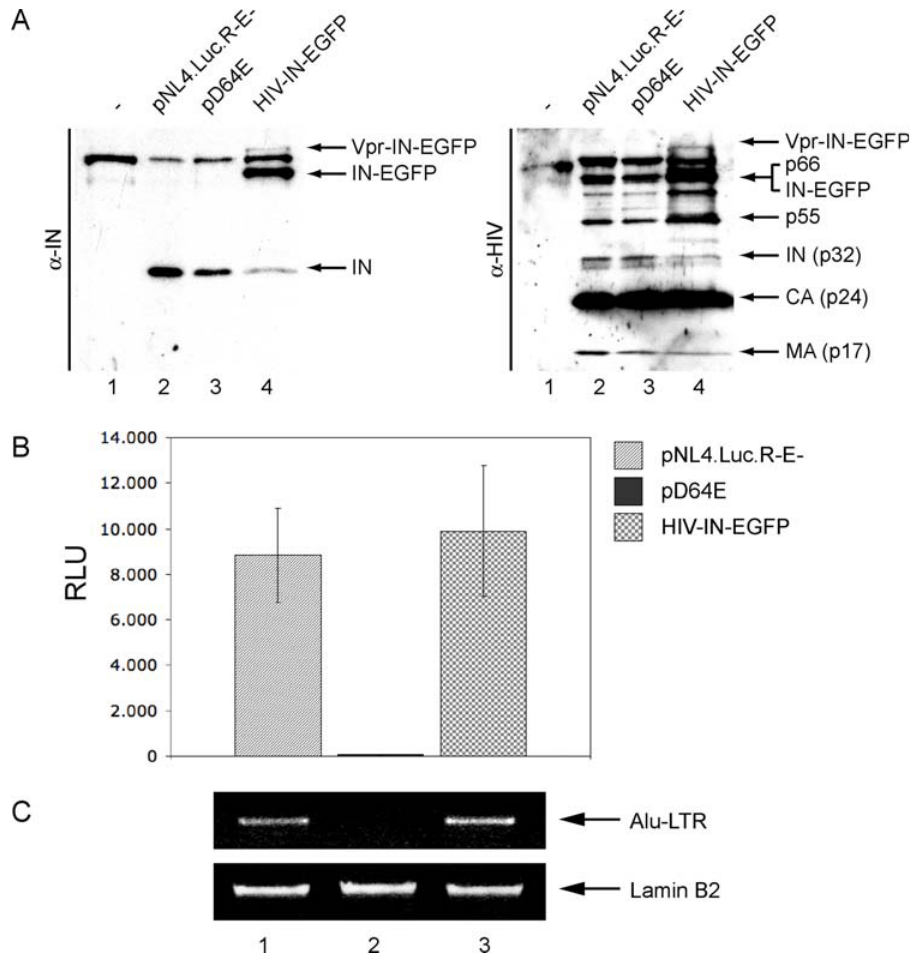
Figure 1. IN-EGFP trans-incorporation through Vpr produces intact and infective viral particles. (A) IN-EGFP is incorporated into intact HIV-1 virions. Supernatant from un-transfected control cells (lane 1) or cells transfected with pVSV-G and pNL4-3.Luc.R-E- (lane 2), pD64E (lane 3) or pD64E together with pVpr-IN-EGFP (lane 4) were pelleted by ultra-centrifugation through a 20% sucrose cushion and analyzed by western blot using antibodies anti-IN (left panel) or with an anti-HIV-1 human serum (right panel). (B) HIV-IN-EGFP virions are infective. Ultracentrifuged supernatants from cells producing the indicated viruses were normalized for p24 content and used to infect HeLa cells. Seven days post-infection cell lysates were analyzed for luciferase activity. Luciferase activity values were normalized for protein content of lysates and expressed as relative light units (RLU). (C) HIV-IN-EGFP virions integrate in the cellular genome. DNA extracted from HeLa cells infected for 24 hours with a NL4-3.Luc.R-E- (lane 1), D64E (lane 2) or HIV-IN-EGFP (lane 3) viruses pseudotyped with VSV-G were amplified with primers specific for the Alu-LTR (to analyze the fraction of integrated HIV-1 DNA-upper panel) and for the lamin B2 cellular gene (to standardize the total amount of extracted DNA- lower panel).